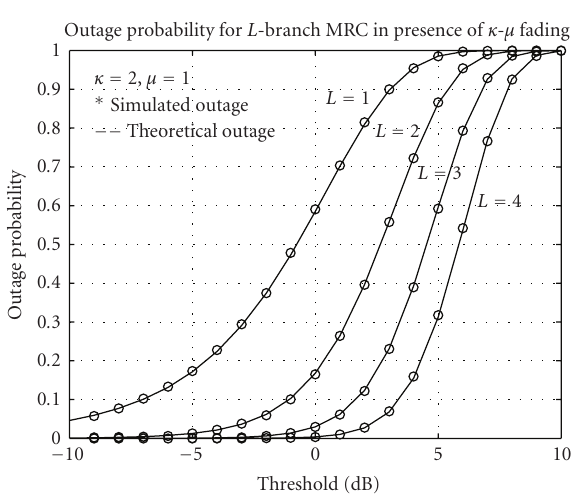
Figure 5: Outage probability for κ = 2 and μ =